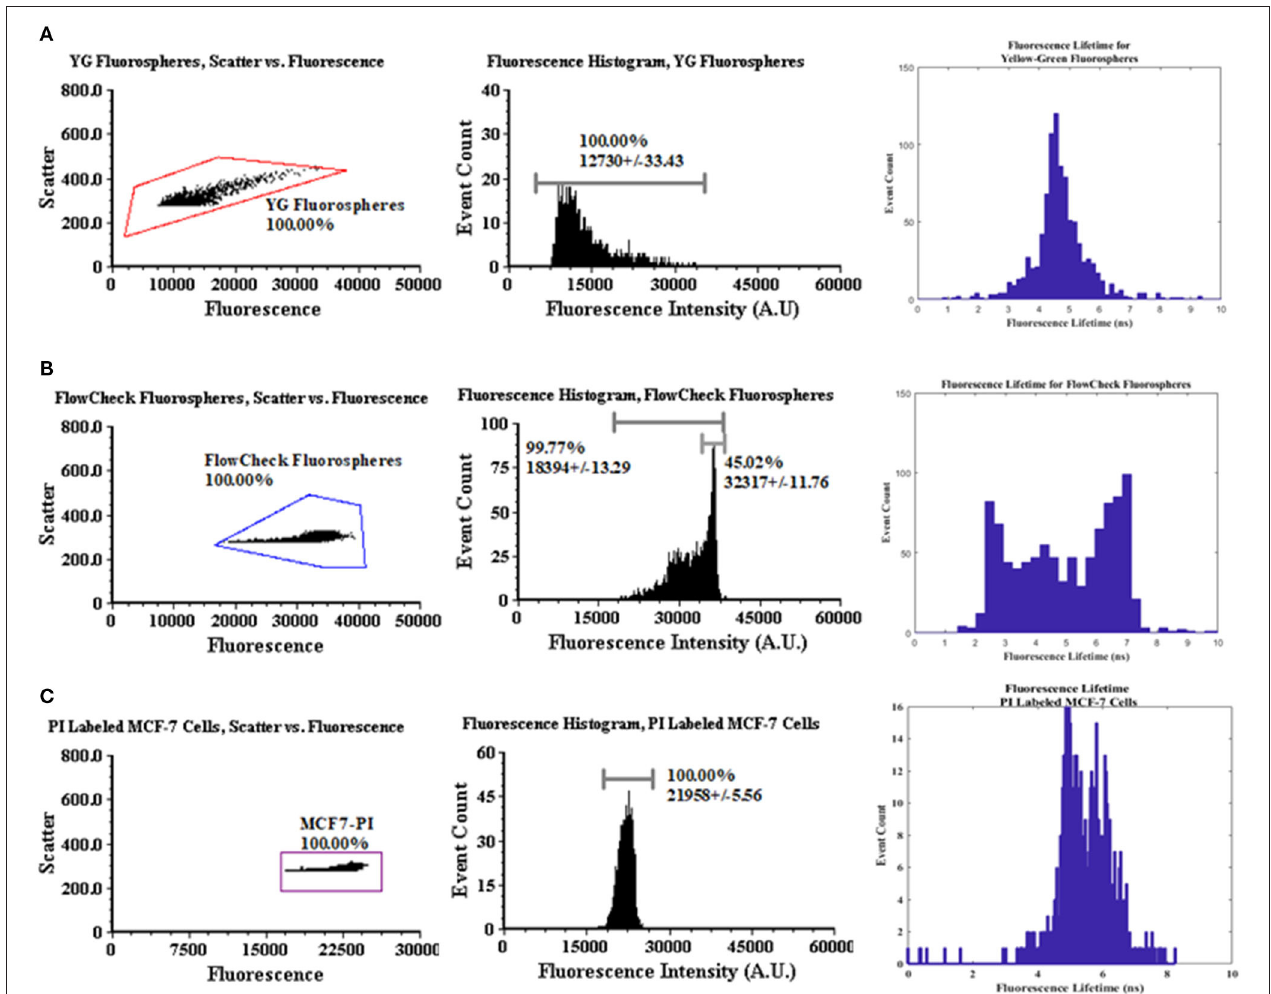
FIGURE 2 | Fluorescence and reference waveforms plotted, and resultant frequency spectrums analyzed offline in MATLAB for (A) YG fluorospheres, (B) FlowCheck ® fluorospheres, and (C) PI-labeled MCF-7 cells.